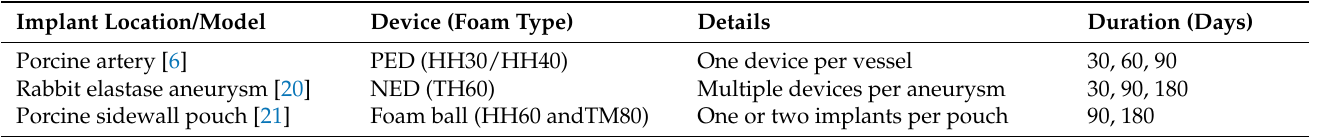
Table 1. Various animal studies with implant locations as well as the SMP foam devices implanted.